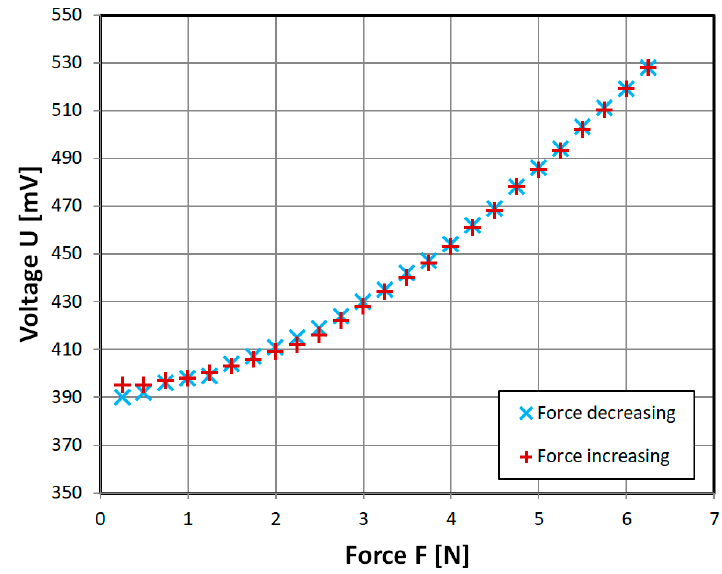
Figure 12. Obtained experimental characteristic of developed ‘straight’ sensor, with variable mutual inductance tuned for minimum at 0 N. Sinusoidal driving current of 700 mA, 432 Hz.